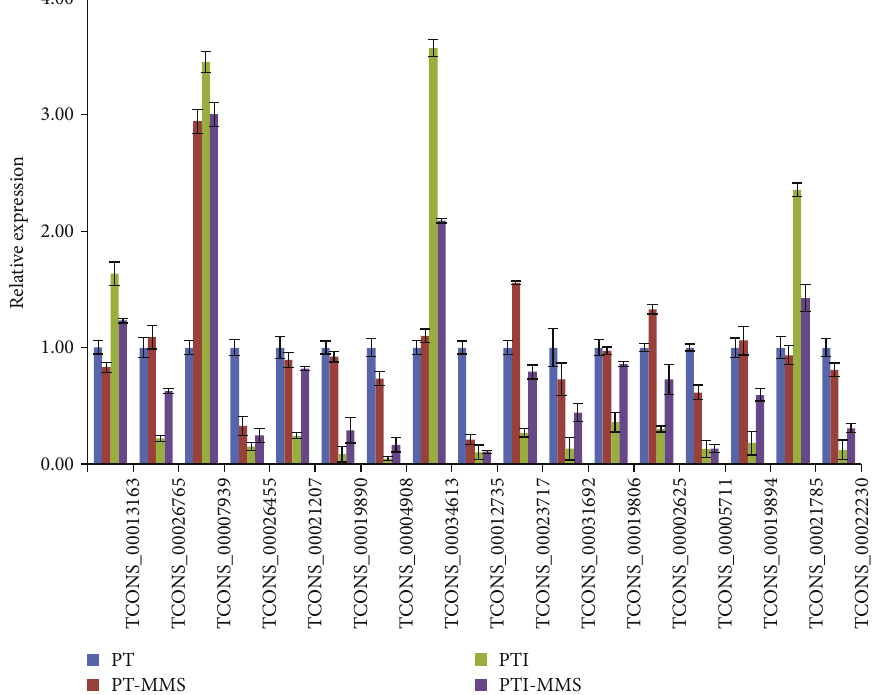
Figure 4: Changes in the relative expression levels of lncRNAs in P. tomentosa . Potential target genes of phytoplasma-responsive